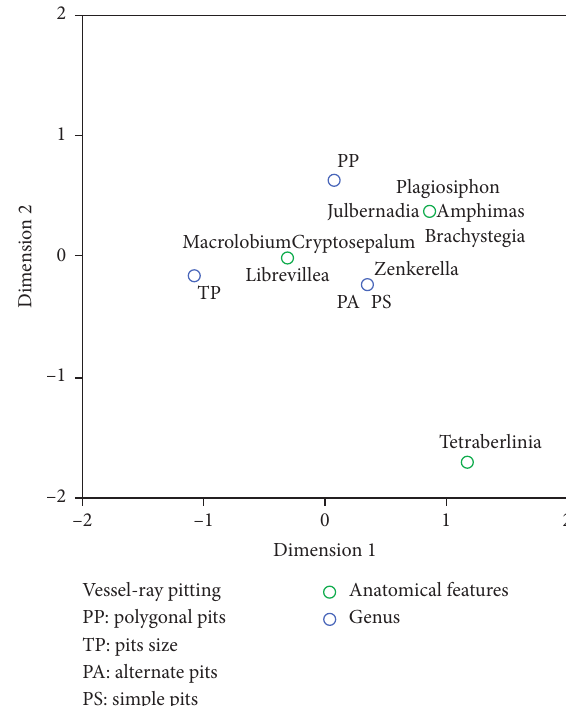
Figure 3: Setting of vessel-ray pitting within Ekop’s